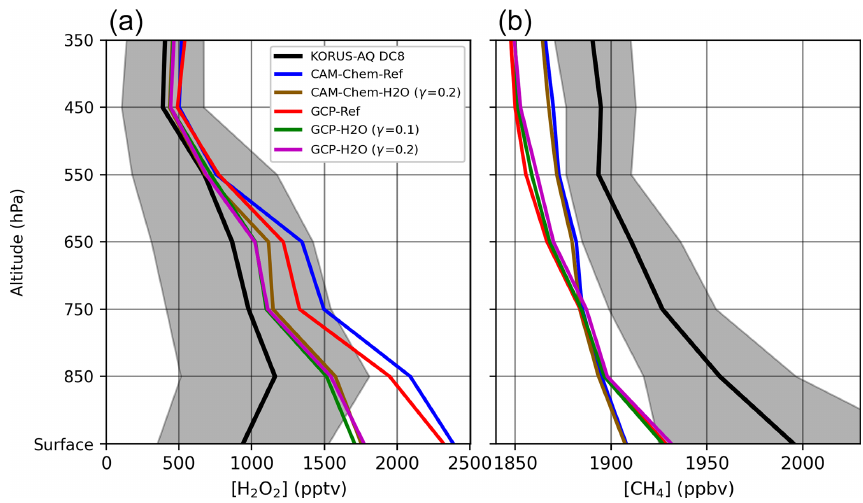
Figure B1. Average H 2 O 2 profiles (a) and CH 4 profiles (b) for KORUS-AQ. The mean (black line) and standard deviation (shaded grey) of the DC-8 observations are calculated for each 100hPa bin, and only the mean is shown for model